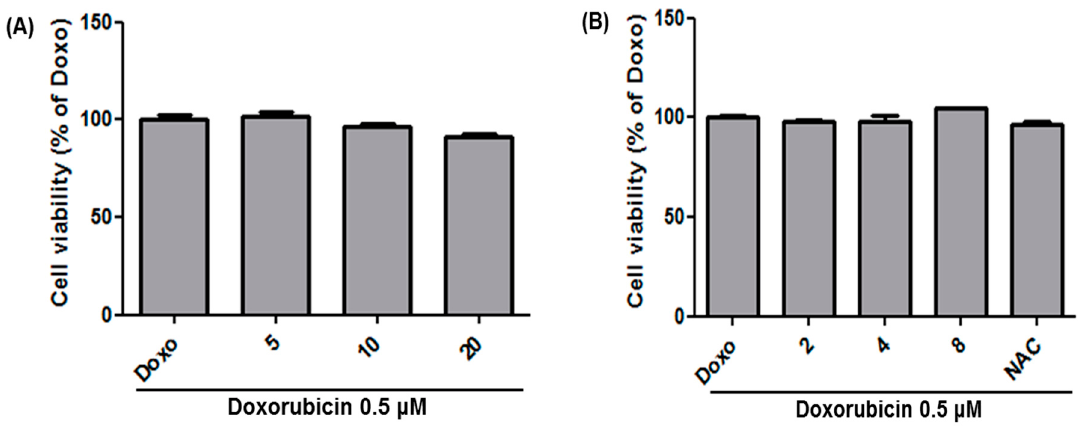
Figure 1. Cell viability of human dermal fibroblasts (HDFs) treated with Dendranthema zawadskii (DZ) extract. Cell viability was measured by the MTT assay. Cells were treated with 0.5 µ M doxorubicin for 4 h. After 24 h incubation, cells were treated with DZ extract and incubated for 3 days. Cell viability was measured at 550 nm. ( A ) Cell viability with 5, 10, 20 μ g/mL DZ extract. ( B ) Cell viability with 2, 4, 8 μ g/mL DZ extract and 5 mM N-acetyl-L-cysteine.